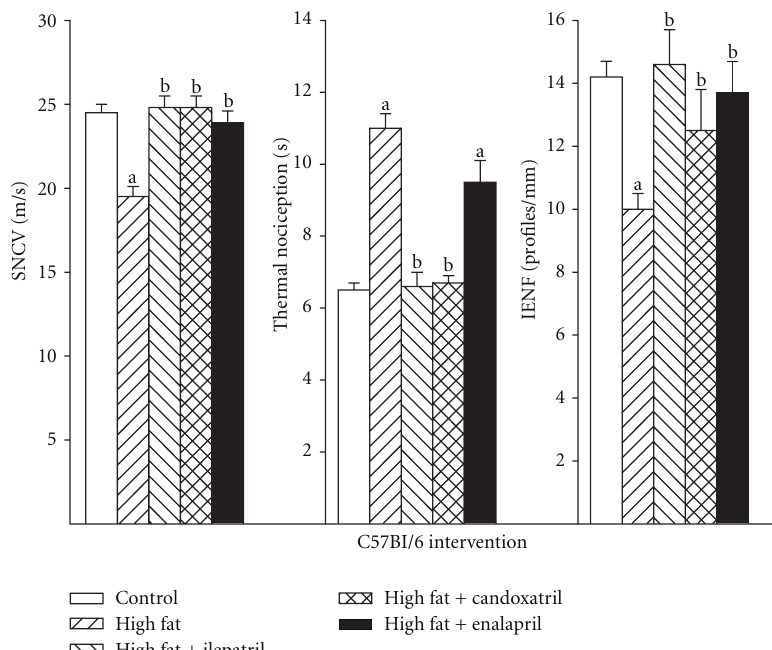
Figure 7: Sensory nerve conduction velocity, thermal nociception, and intraepidermal nerve fiber profiles for C57Bl/6J mice fed a normal or high-fat-containing diet for 24 weeks with or without ilepatril, candoxatril, or enalapril for the last 12 weeks (intervention protocol). Control (open bar), high fat (right hatch bar), high fat + ilepatril (left hatch bar), high fat + candoxatril (cross hatch bar), and high fat + enalapril (closed bar). Data are the mean ± SEM. The number of mice in each group was the same as shown in Table 2. a, P < 0 . 05 versus control; b, P < 0 . 05 versus high-fat-fed mice.